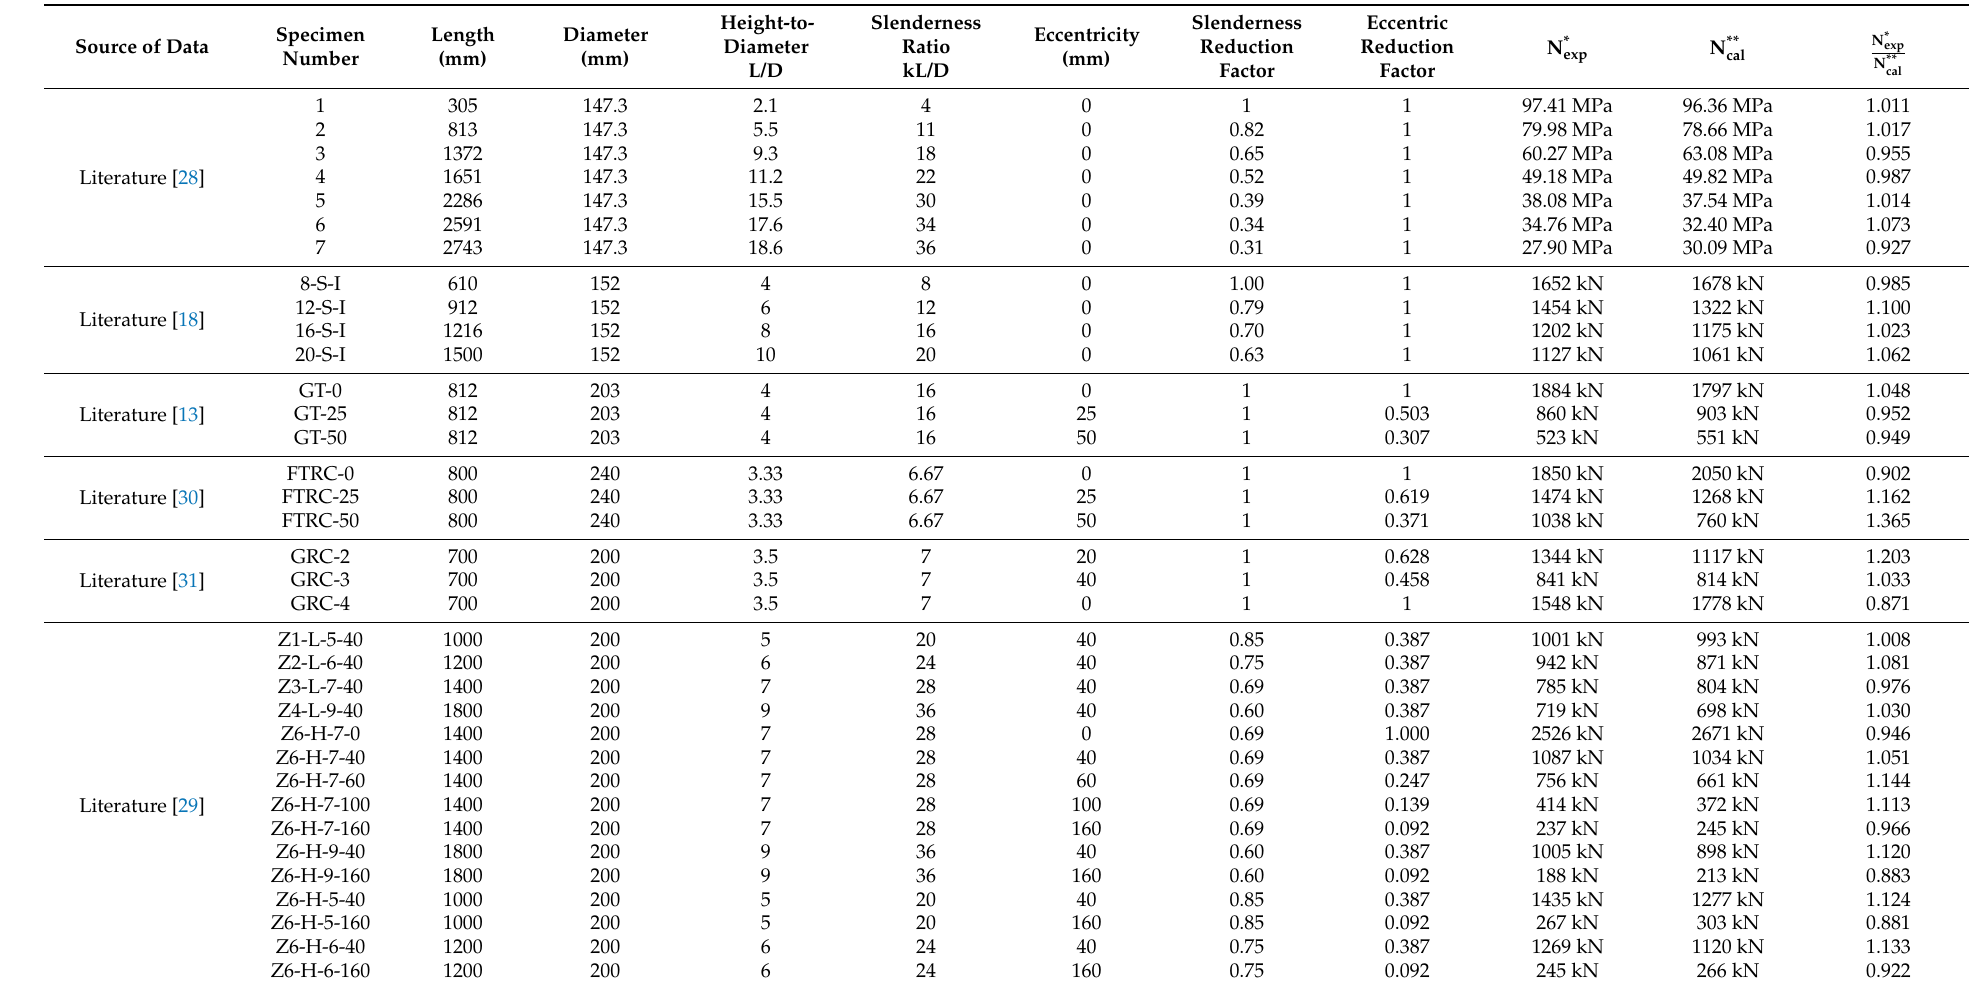
Table 4. The results of the